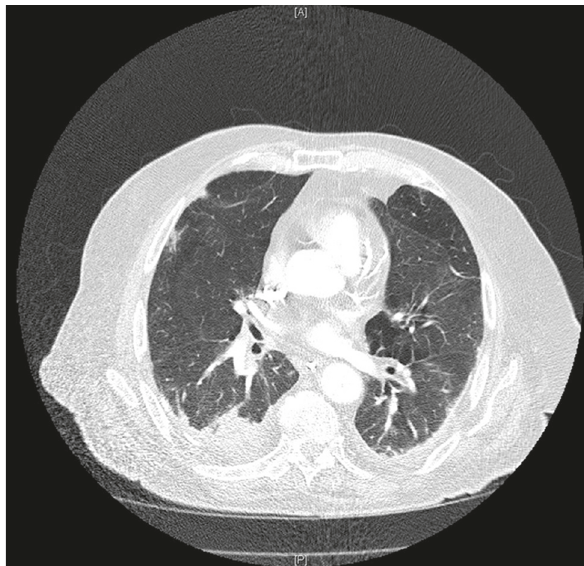
Figure 1: An axial CTchest image of patient 1 demonstrating long- standing bilateral fibrosis and nodular opacities with honey combing and traction bronchiectasis affecting the left lung.